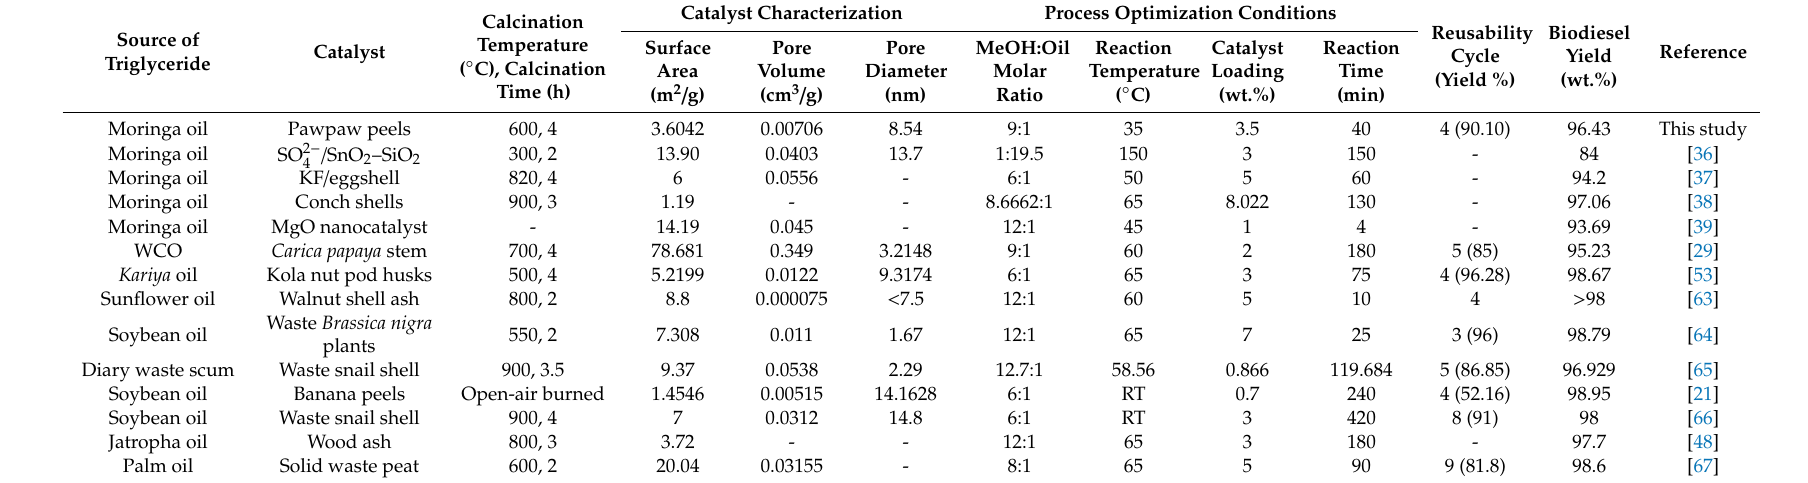
Table 4. Comparison of heterogeneous catalyst characterization, process optimization and biodiesel yield via transesterification. Source of